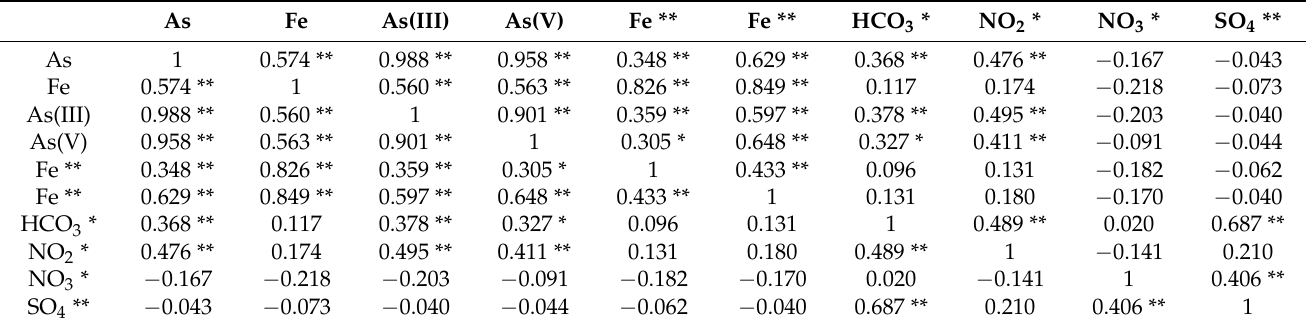
Table 6. Pearson correlation analysis between As and the main redox ions in the Sanhuhe Plain ( n =